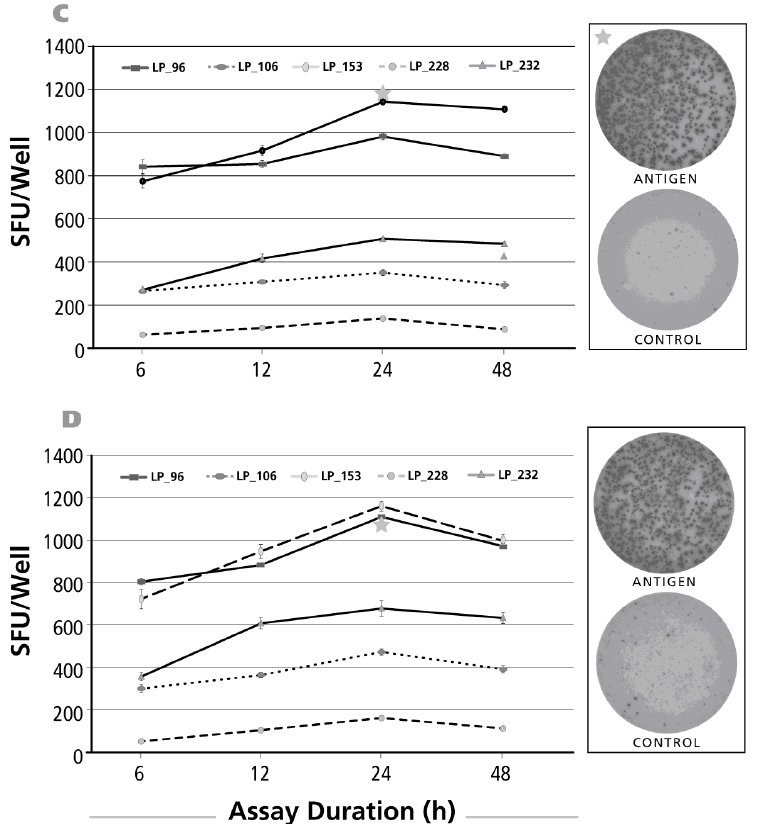
Figure 6. Kinetics of the IFN- γ recall response by Th1 cells. The legend to Figure 2 applies, except that an IFN- γ ELISPOT assay was performed with donors and antigens that scored positive for IFN- γ . Panel ( A ) shows CMV gr.2 antigen-triggered IFN- γ production that requires antigen processing; in Panel ( B ) the results for testing a pool of 15-mer peptides is shown—these peptides cover the sequence of CMV protein pp65—such peptides can bind directly to HLA-Class II molecules and do not need processing; Panel ( C ) shows the kinetics of IFN- γ production after stimulation with a nine amino acid long peptide of CMV that covers amino acid positions 495–503 of pp65 protein. This CMV pp65 (495–503) peptide is a well-defined HLA-A2-restricted CMV determinant and all donors tested in C were HLA-A2 positive; Panel ( D ) shows the kinetics of the CEF peptide pool induced IFN- γ recall response.